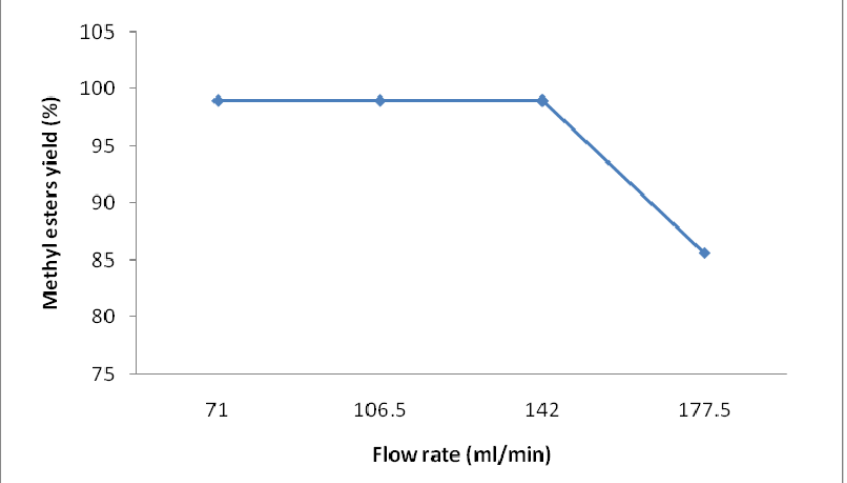
Figure 3. Effect of flow rate on yield of methyl esters from coconut oil (Catalyst concentration 1 wt% of oil, molar ratio methanol:oil 7:1, temperature 65 °C, stirring speed 800 rpm, residence time 21.04